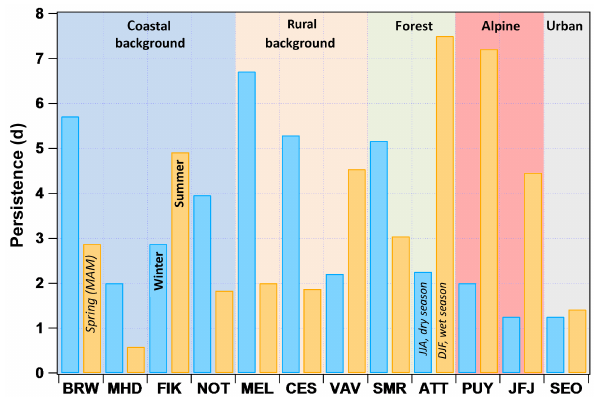
Figure 5. Persistence of CCN number concentrations at SS = 0.2% in days for winter (DJF) and summer (JJA). Note that for BRW there were not sufficient data during summer, so spring values are shown, and since ATTO is located in the tropics, wet and dry seasons are different as